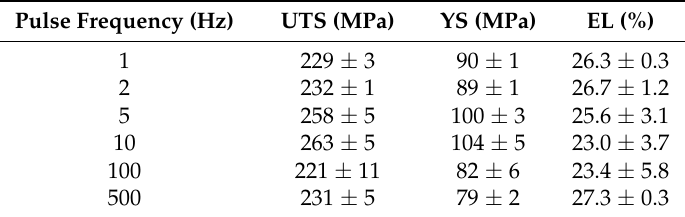
Table 3. Tensile properties of the samples fabricated by different pulse frequencies.